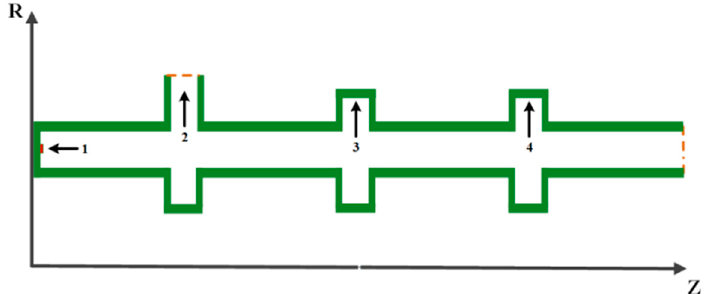
Figure 5. ( a ) The first harmonic current versus different modulation voltage: full lines show theoretical results while dotted lines show simulation results. ( b ) The velocity dispersion versus displacement Z.